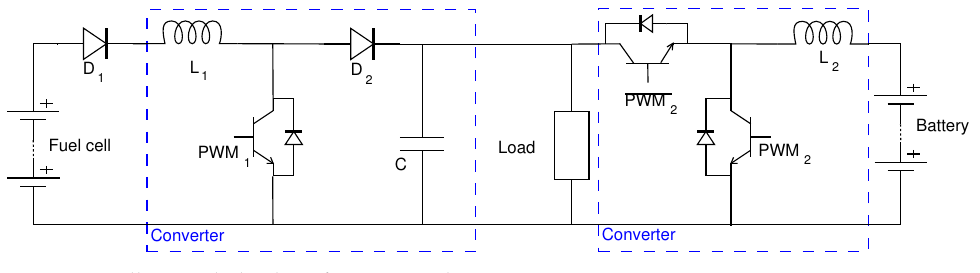
Figure 7. Full-active hybrid configuration